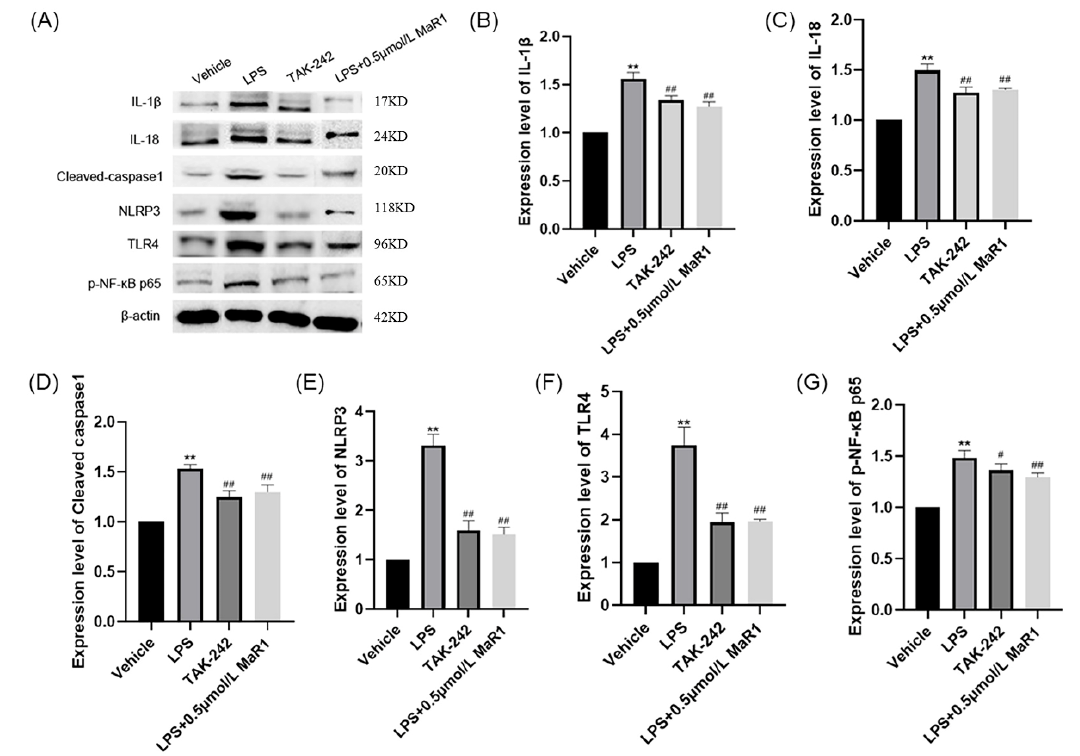
Figure 7. Levels of IL-1 β , IL-18, cleaved-caspase1, TLR4, NLRP3, and pNF- κ B p65 were determined by Western blot. ( A ) western blot images; ( B – G ) The β -actin was used as an internal reference, statistical bar graph of protein expression levels; ** p < 0.01, compared to the Vehicle group; # p < 0.05, ## p < 0.01, compared to the LPS group.